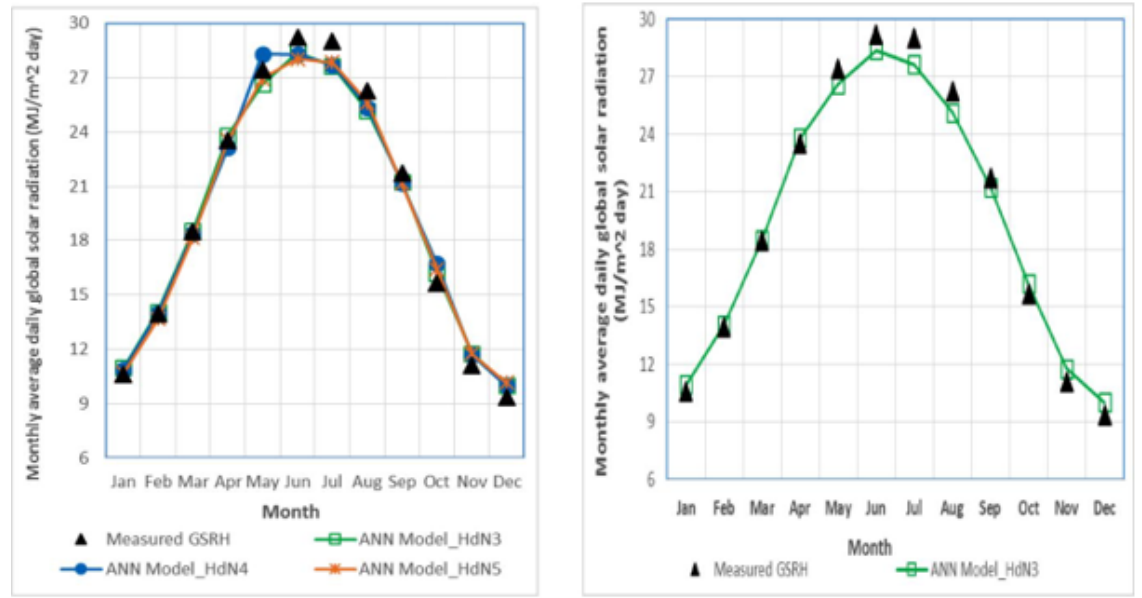
Figure 2. Performance of the ANN models compared with the measured data at New Borg-El-Arab, (a) all models, (b) best model (Model 1; 2-3-1)